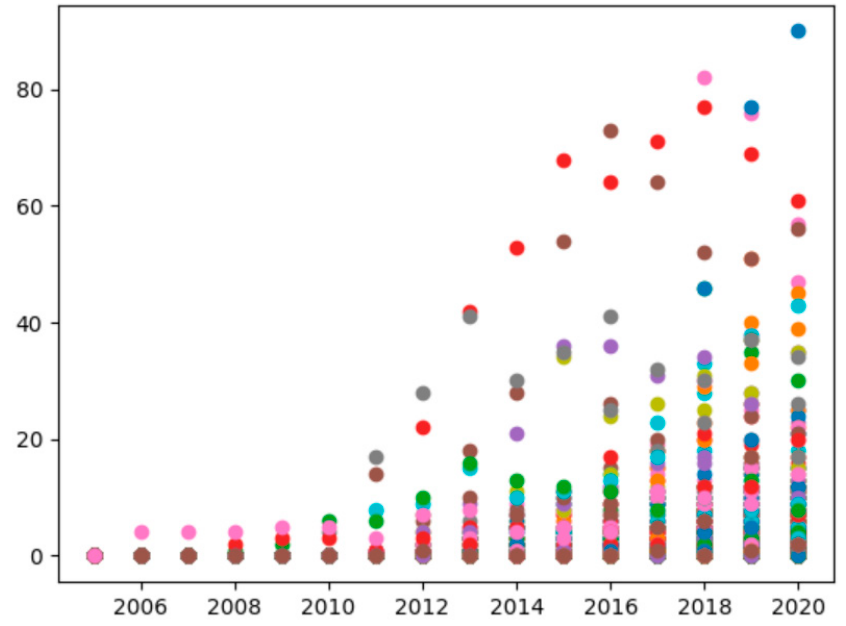
Figure 4. Citation statistics of papers over the years.